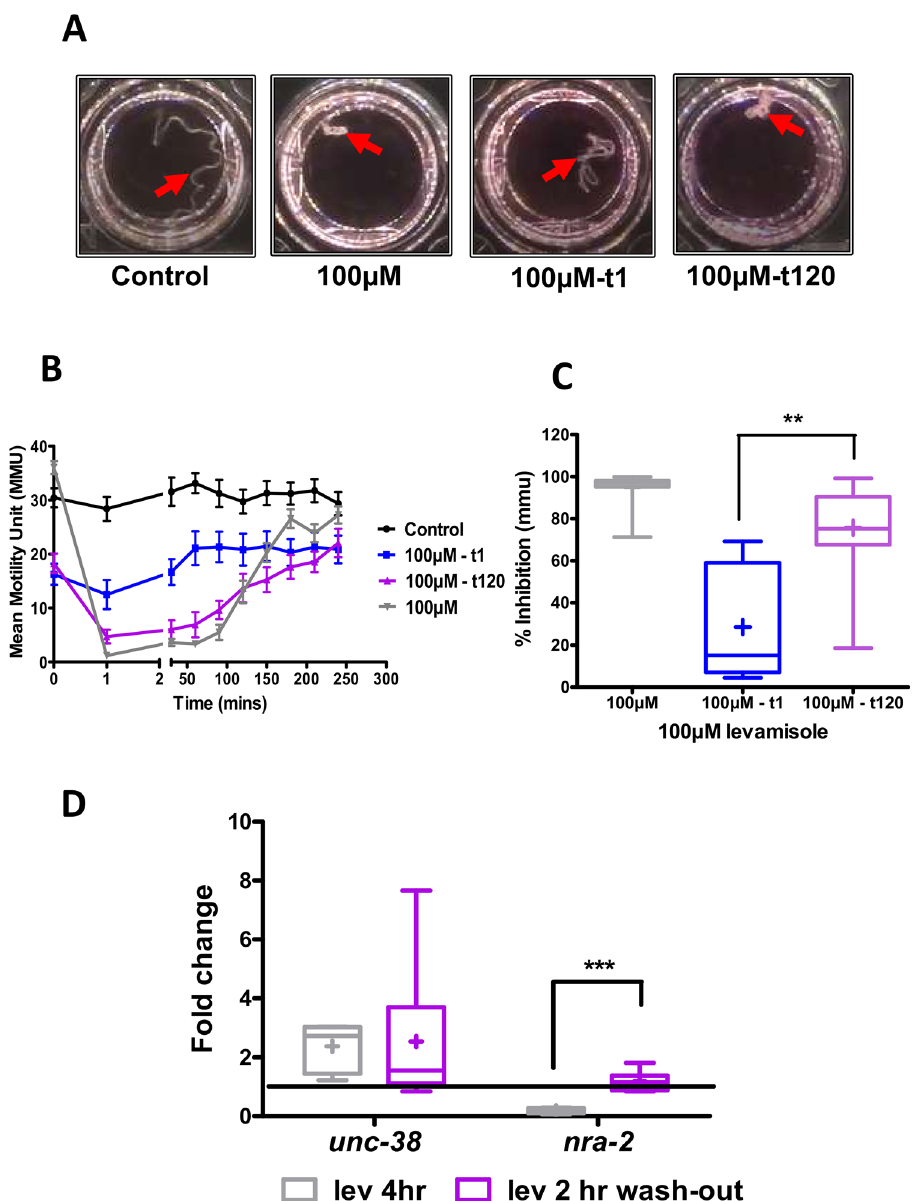
Figure 8. Treated adult female B. malayi become re-sensitive to levamisole after 120 min in RPMI media. ( A ) Shows images of worms under spastic paralysis for t-0, t-1 and t-120 worms. ( B ) Worms treated in levamisole recover after 4 h (t-0; grey). These worms were transferred into RPMI media and treated with a second dose of levamisole after 1 min (t-1; blue) and 120 min (t-120; purple). Control worms (black) were treated with water. ( C ) Histogram of the spastic paralysis effect of levamisole on the above worms. Inhibition of motility in t-1 worms were significantly lower compared to the t-120 worms (Student’s t-test; p < 0.005; n = 8 over two biological replicates). ( D ) Transcript levels of nra-2 in worms recovered under levamisole after the first 4 h (t-0 worms) and in worms moved to fresh RPMI media for 120 min (t-120). N = 6 over two biological